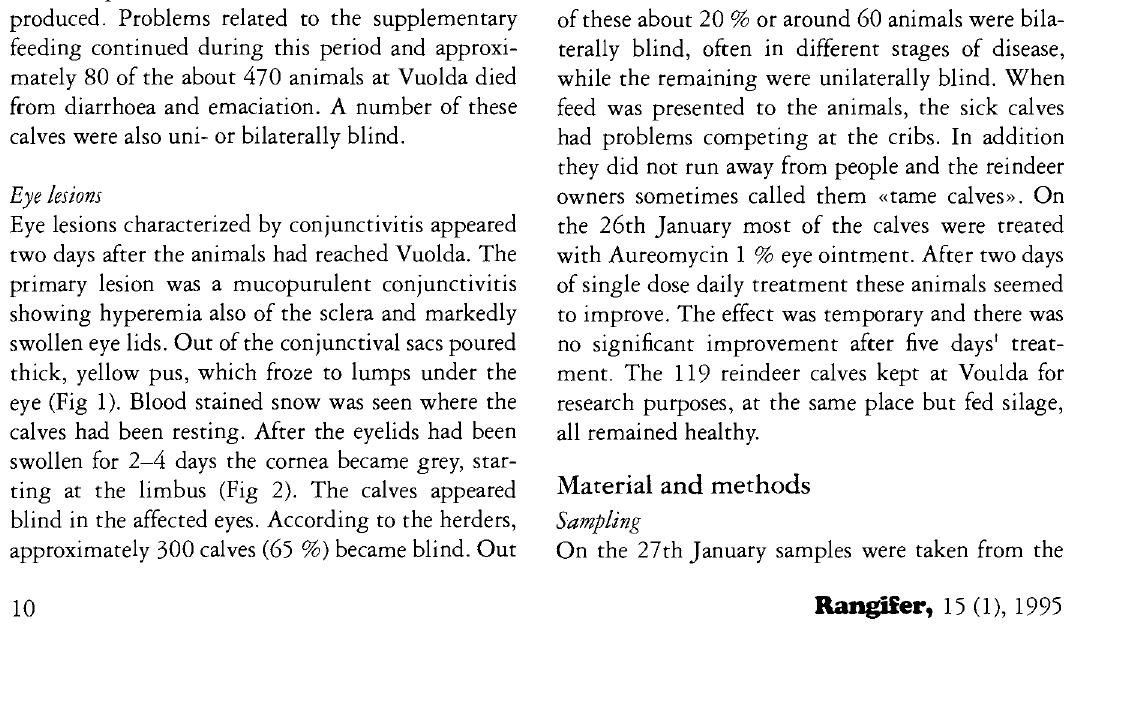
Fig. 2. Eye of reindeer calf. Note the very marked peri pheral swelling of the cornea. Photo: B.